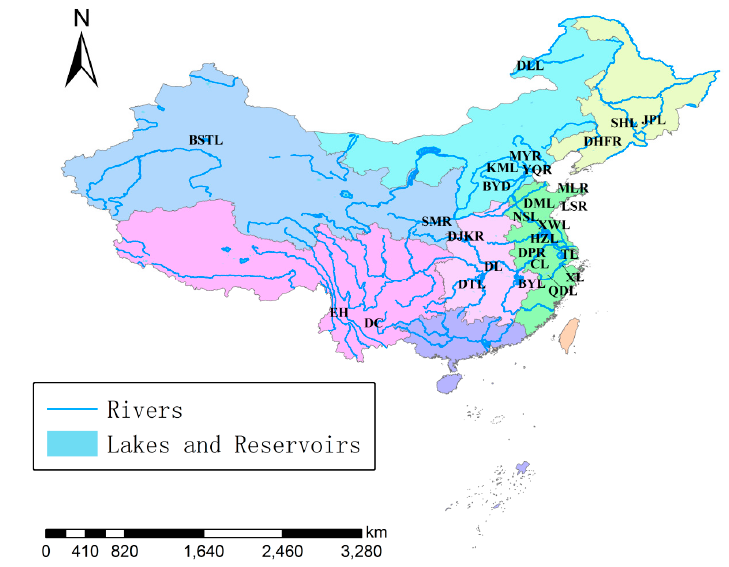
Figure 1. The locations of 27 representative lakes in China.